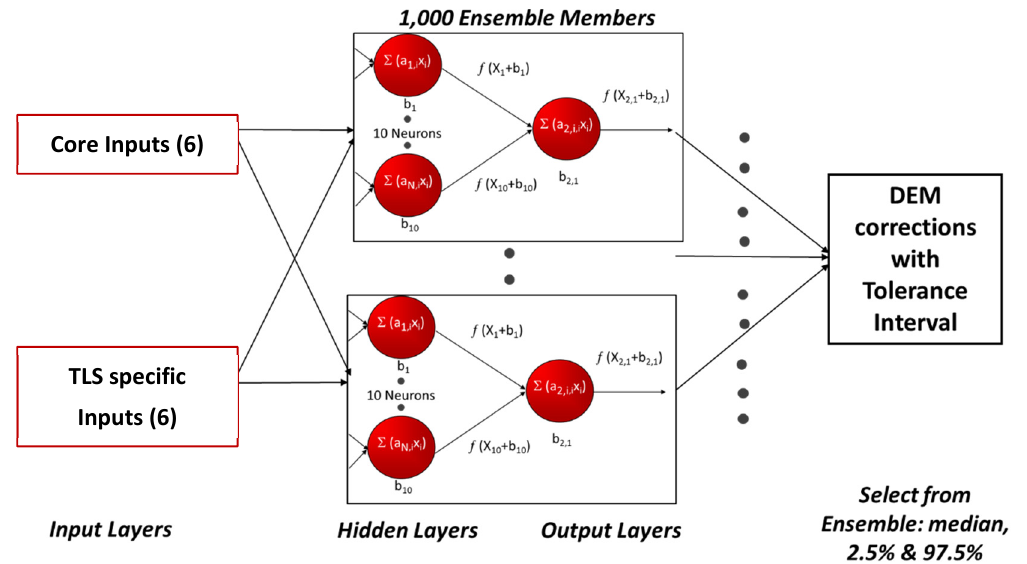
Figure 5. Ensemble neural network approach.